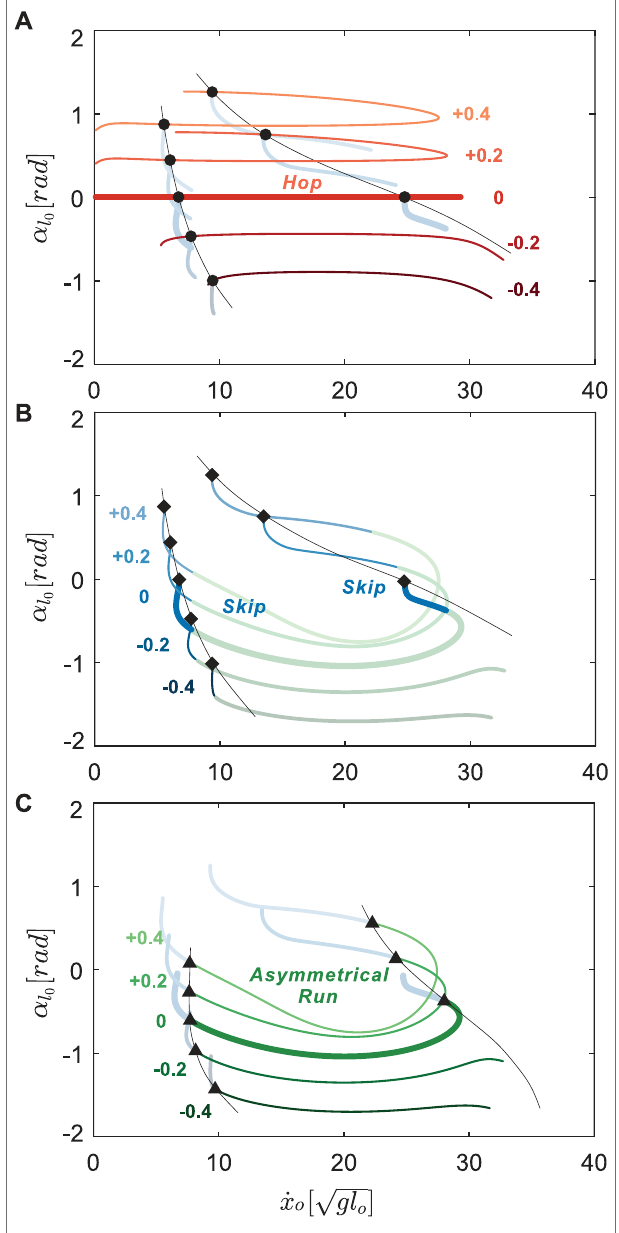
FIGURE 7 | Hopping (A), skipping (B) , and asymmetrical running gait branches (C) with φ l (cid:2) φ r ∈ [− 0 . 4 , − 0 . 2 , 0 , + 0 . 2 , + 0 . 4 ] rad. Thicker colored lines represent the nominal gait structure ( Figure 4 ). Hop-skip transitions are circles in (A) and (B) , skip-running transitions are triangles in (C) . Thin black lines trace gait transitions across varying neutral leg swing angles. The higher speed hop - skip transition point showed more variation in speed with changes in NLSA than the lower speed transition